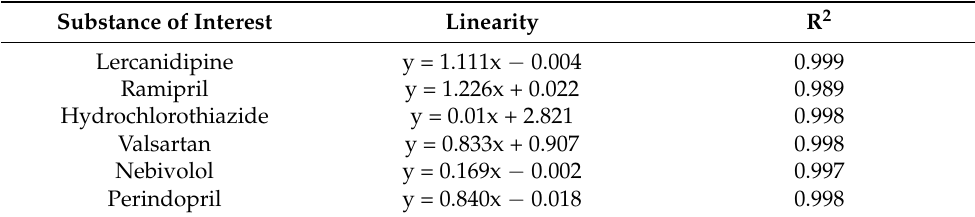
Table 1. Linear regression equations for the test drugs determined with precipitation procedure. Substance of Interest